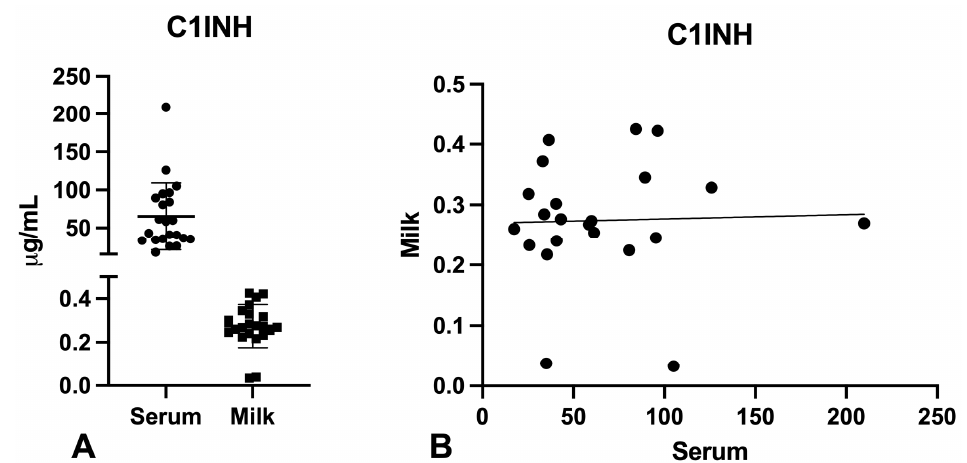
Figure 4. Evaluation of C1 inhibitor (C1INH) levels in serum and milk samples. C1INH levels were quantified by using a commercial ELISA kit ( A ). C1INH levels in milk and serum were correlated by Pearson test. No correlation was found between serum and milk concentrations ( B ).